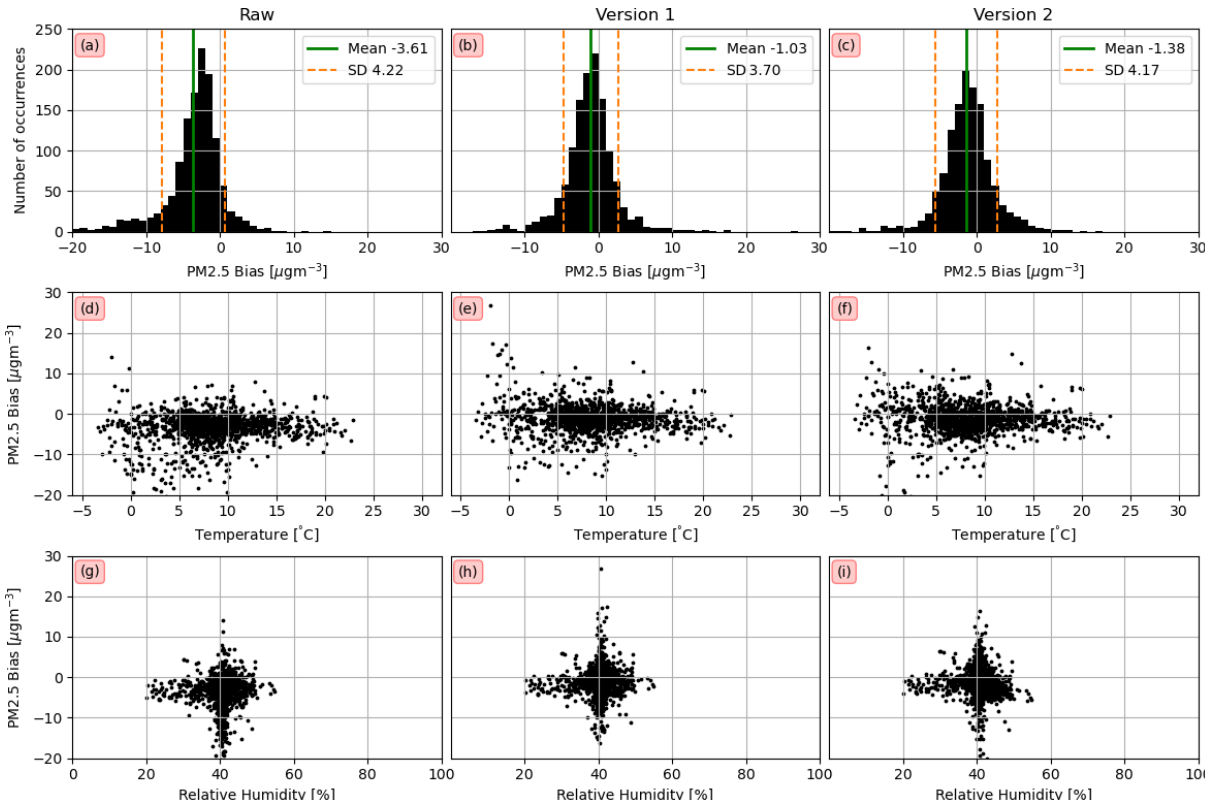
Figure 10. A comparison of hourly means of the raw (a, d, g) , version 1 (b, e, h) , and version 2 (c, f, i) data from the ES-642 and the TEOM at the St Albans site. Panels (a, b, c) show histograms of bias (ES-642-TEOM) with the mean (green line) and ± 1 standard deviation (orange dashes) indicated. Panels (d, e, f) show scatterplots of the bias against temperature, and panels (g, h, i) show scatterplots of bias against humidity. The instrument ID for the ES-642 instrument is